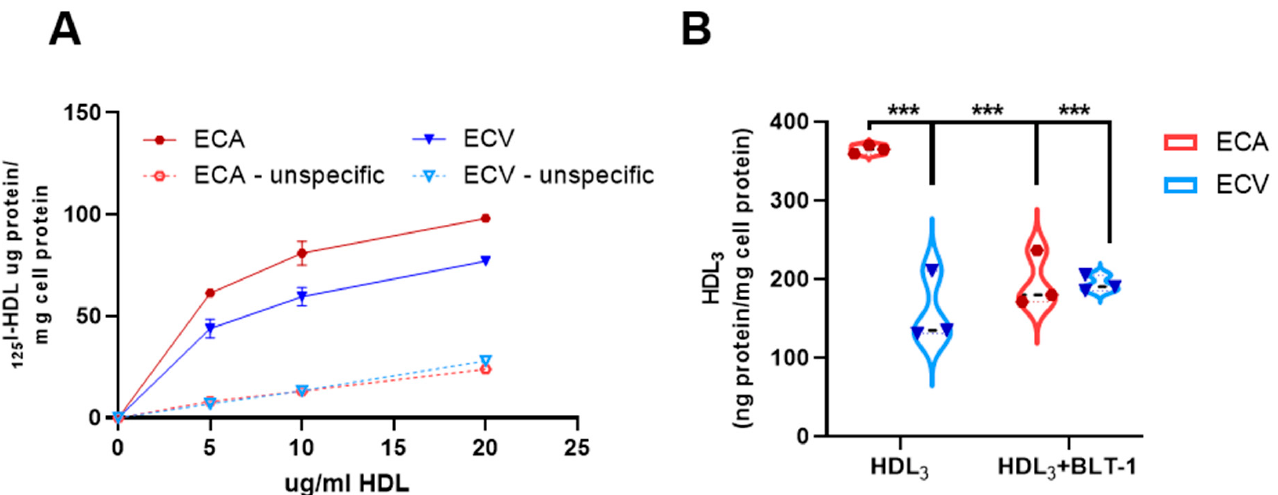
Figure 4. ( A ) Specific binding of increasing amounts of 125 I-labelled HDL to ECA (solid red line) and ECV (solid blue line) at 37 ◦ C was investigated and showed a higher binding of HDL to ECA than ECV. Unspecific binding (dashed lines) at 37 ◦ C in excess of unlabeled HDL is also shown. ( B ) A total of 10 ug/mL of 3 H-labelled HDL 3 were offered to ECA and ECV ( n = 3) in the presence or absence of the SR-BI inhibitor BLT-1. Selective uptake in ECA was increased compared to ECV, and this increase dropped upon treatment with BLT-1. Nevertheless, a residual selective uptake of HDL occurred in ECA. Two-way ANOVA with Sidak’s post-hoc test for multiple comparisons was used, *** p < 0.001.